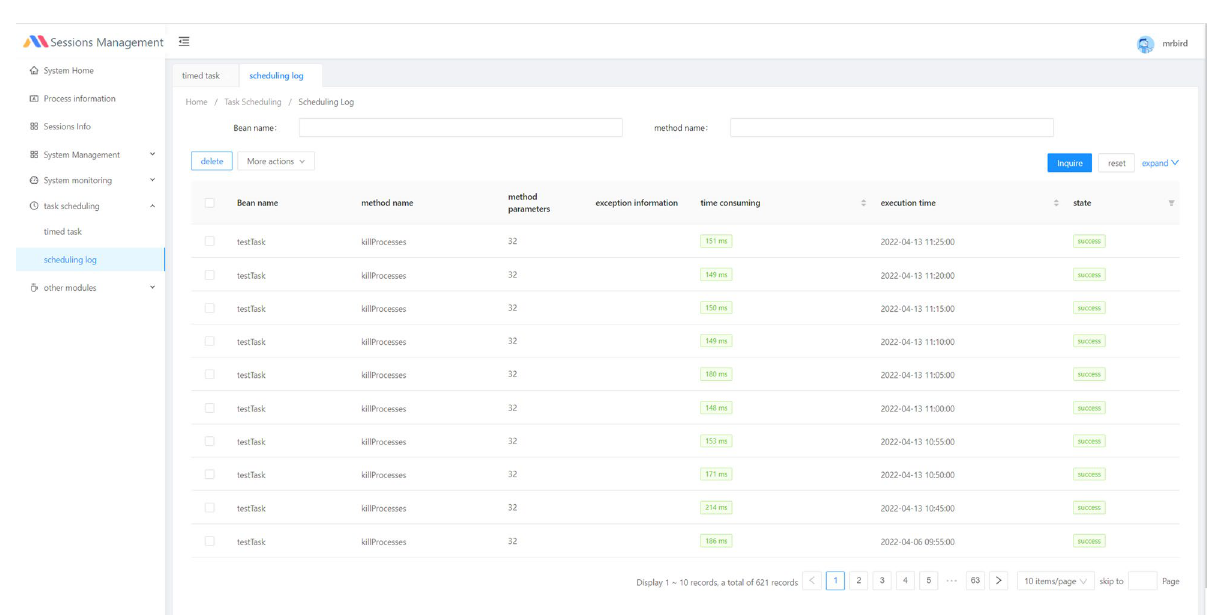
Figure 3. Process management log interface in the session